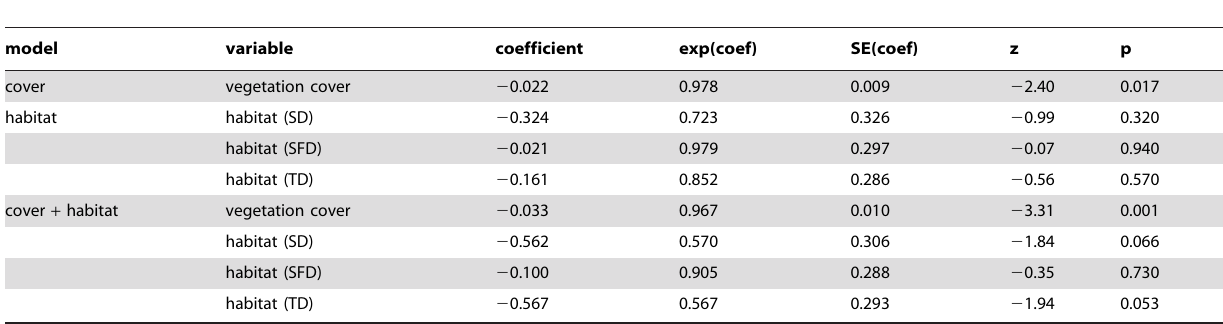
Table 1. Mixed-effects Cox proportional hazards models for the survival of Kentish Plover’s nests in three beaches located in Eastern Spain.